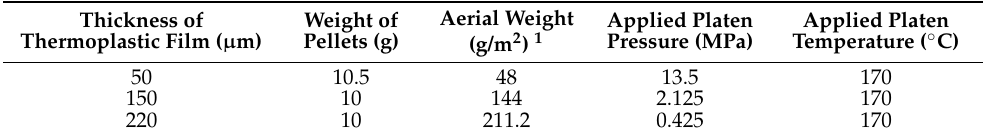
Table 1. Thermoplastic film fabrication parameters.